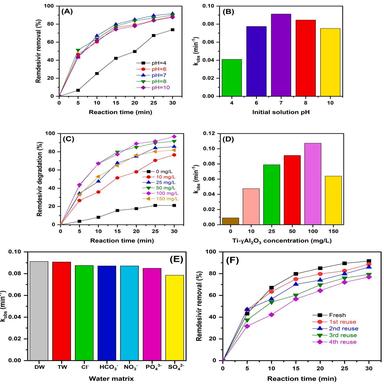
The effect of initial solution pH (A, B), catalyst concentration (C,D), anions (E), and recycle time (F) on removing RDV in the UVA/TAX (otherwise mentioned, TAX: 50 mg/L; RDV: 10 mg/L, pH: 7).